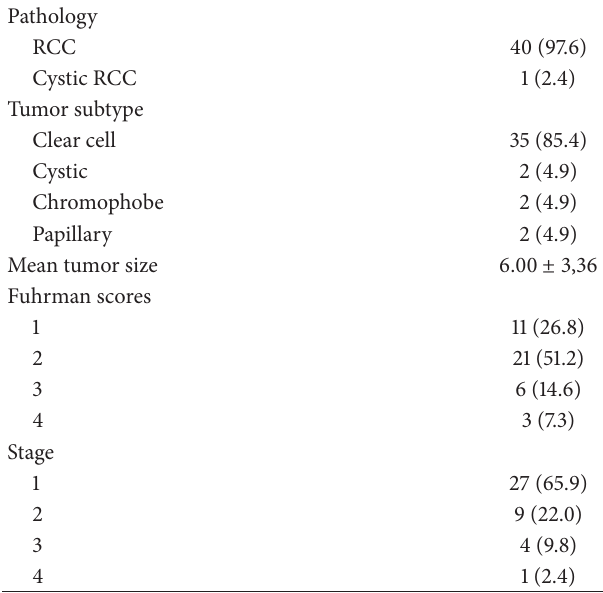
Table 2: Tumor characteristics of the RCC patients.